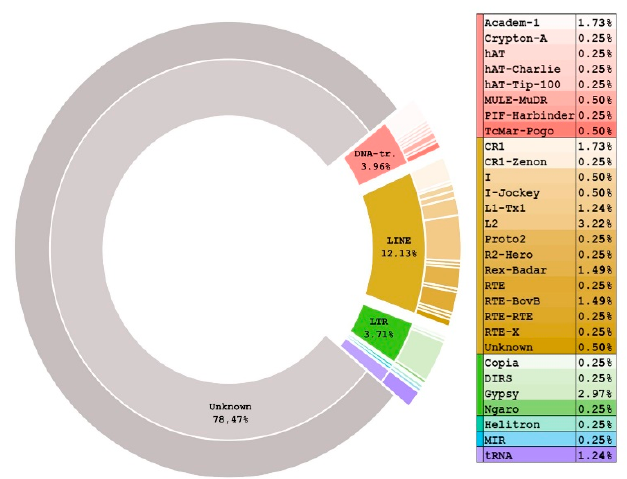
Figure 1. Donut plot of repetitive sequences in the genome of Strongylocentrotus purpuratus, version 5.0. The inner circle corresponds to the type of REs, the outer to the REs family.